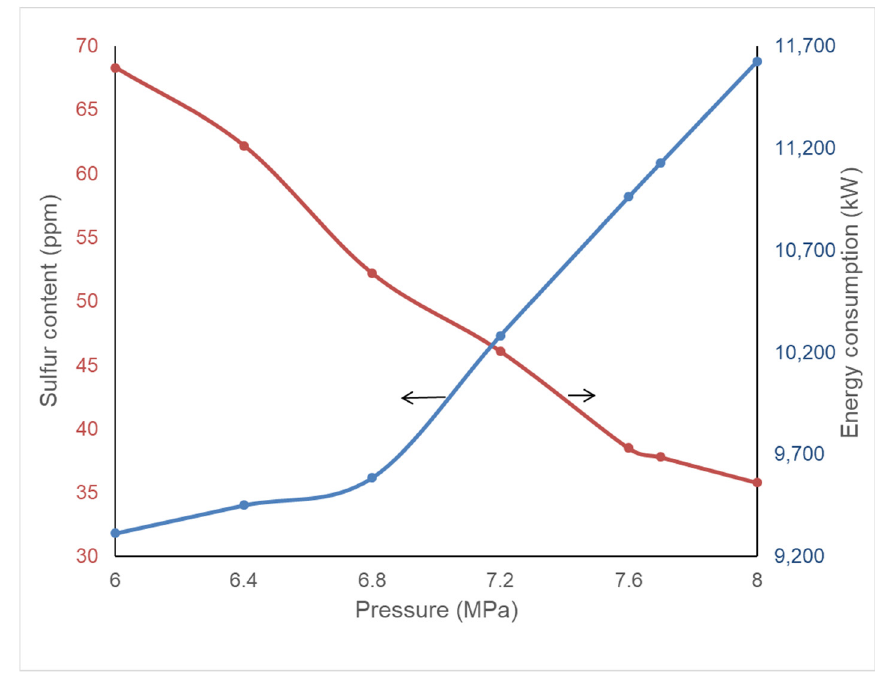
Figure 4. Effect of reaction pressure (reaction temperature 318 °C).